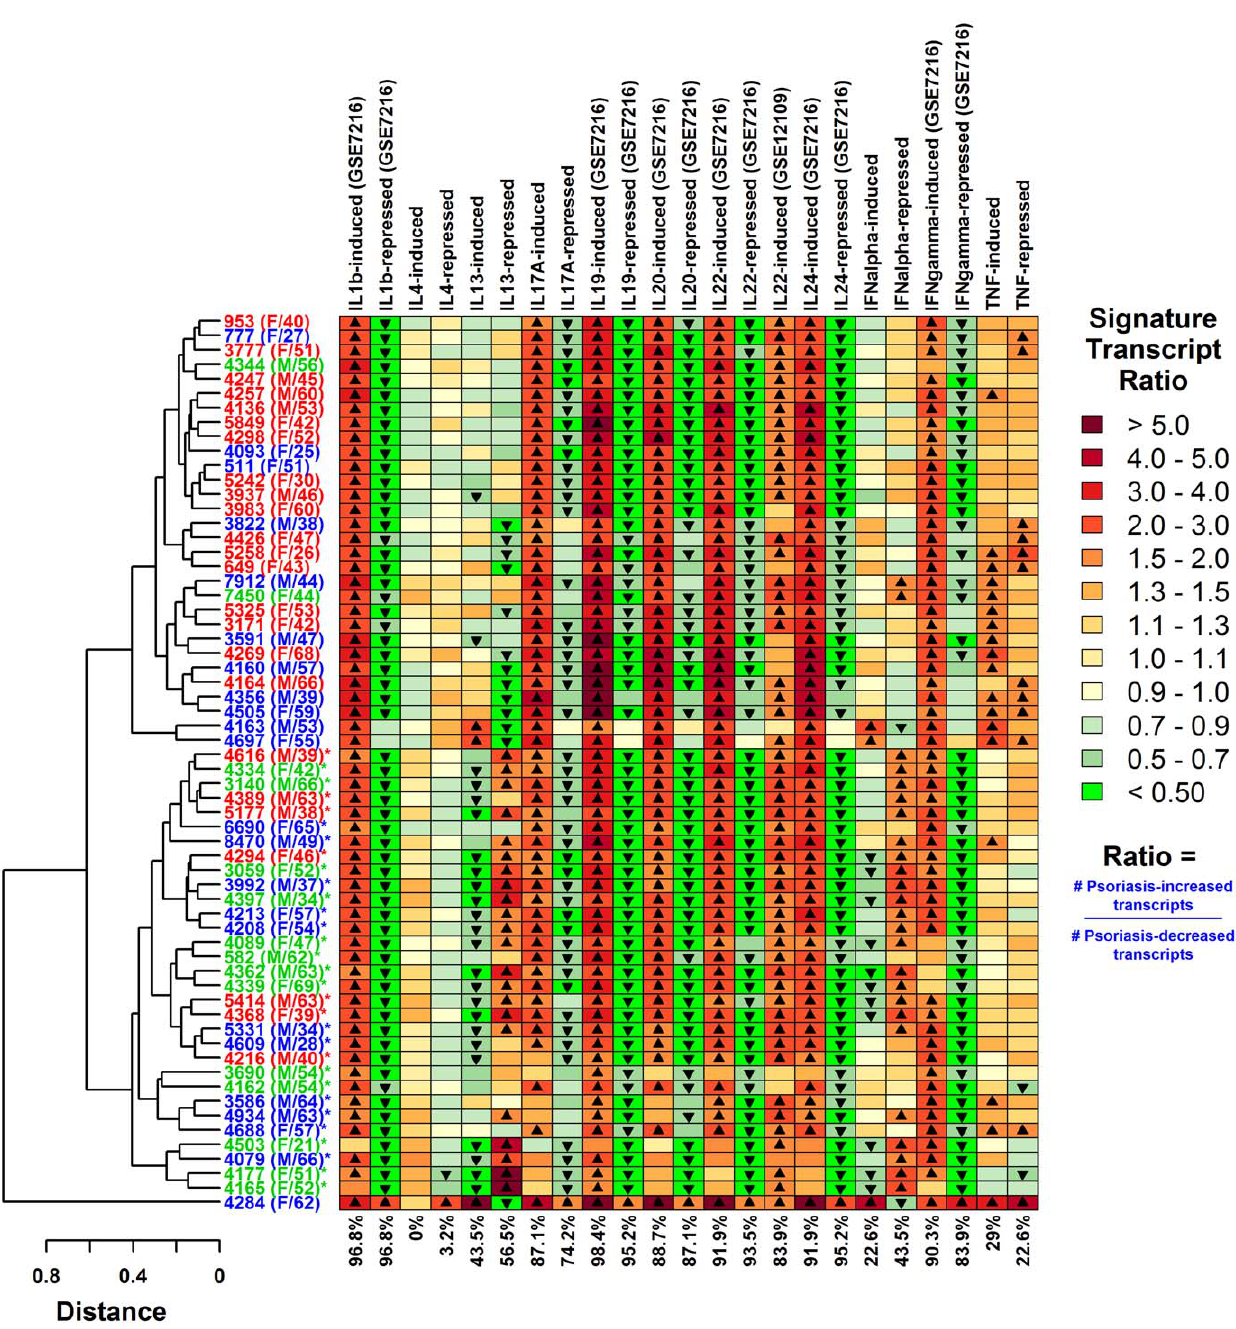
Figure 2. Sub-division of psoriasis lesions into IL-13-strong and IL-13-weak groups based on genome-wide expression profiles. We identified 32 sets of 1000 cytokine-responsive transcripts based upon in vitro exposure of keratinocytes to cytokines. For each set (columns) and subject (rows), chart colors denote the ratio of PP-increased to PP-decreased transcripts (see scale and Methods). Up-triangles indicate significant bias towards PP-increased expression (FDR-adjusted P , 0.05 and ratio value . 1.50). Down-triangles indicate significant bias towards PP-decreased expression (FDR-adjusted P , 0.05 and ratio value , 0.667). Percentage values (bottom) denote the total fraction of subjects with significant patterns in either direction. Asterisk symbols identify subjects associated with the IL-13-weak group (bottom of dendrogram; 31/62 subjects). All other subjects are associated with IL-13-strong patterns (top of dendrogram; 31/62 subjects). Subject label colors are consistent with those in Figure 1 (strong, moderate and weak inflammatory groups). An expanded version of this figure is provided as supplemental material (Figure S7). doi:10.1371/journal.pone.0034594.g002 consistent among subjects (Figures 2 and S7). Among the 1000 from the cohort (i.e., 98.4% of patients). These robust trends transcripts induced by IL-19 treatment in vitro , 75.8% were, on related to IL-1 b , IL-17A, IL-19, IL-20, IL-22, IL-24 and IFN- c average, elevated in lesional skin as compared to non-lesional skin, were replicated with respect to an independent dataset with 28 and this percentage was significantly large in all but one patient patients (Figure S8) [11].